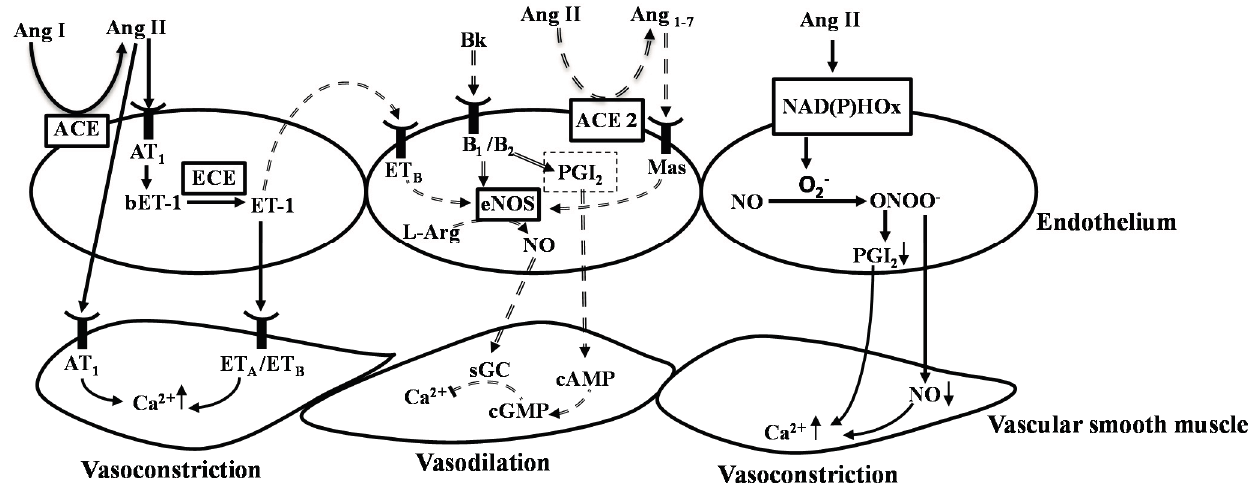
Figure 2. Endothelial dysfunction and blood pressure regulation. Angiotensin converting enzyme (ACE) converts angiotensin I (Ang I) to angiotensin II (Ang II), Ang II binds with angiotensin receptor 1 (AT 1 ) on endothelium cells as well as vascular smooth muscle cells, then AT 1 receptor increases calcium ion (Ca 2+ ) concentration in vascular smooth muscle cells (VSMC) and exerts vasoconstriction. In endothelium cells activation of AT 1 receptor increases the production of bET-1 (big endothelin-1). Endothelin-Converting Enzyme (ECE) converts bET-1 to endothelin-1 (ET-1) and exerts vasoconstriction by activating endothelin A/B receptors (ET A/B ) in the VSMC. In contrast, activation of ET B receptor in endothelium cells mediates vasodilatory effects via release of nitric oxide (NO) by activating endothelial nitric oxide synthase (eNOS). ACE also converts Bradykinin (Bk) into inactive peptides. Bk binds with bradykinin receptor (B 1/2 ) and activates eNOS, which converts L -Arginine to L -Citrulline and produces NO. NO exerts vasodilation by activating cyclic guanosine monophosphate (cGMP) by inhibiting the concentration of Ca 2+ in VSM. In endothelium cells Ang II produces superoxide (O 2 − ) which scavenges NO and produces peroxynitrite (ONOO − ), exerts vasoconstriction effect by limiting the supply of NO to the VSM. Signaling pathways illustrated with solid line arrows are representing vasoconstriction and with compound line arrows are representation vasodilation network. Figure 2 modified from